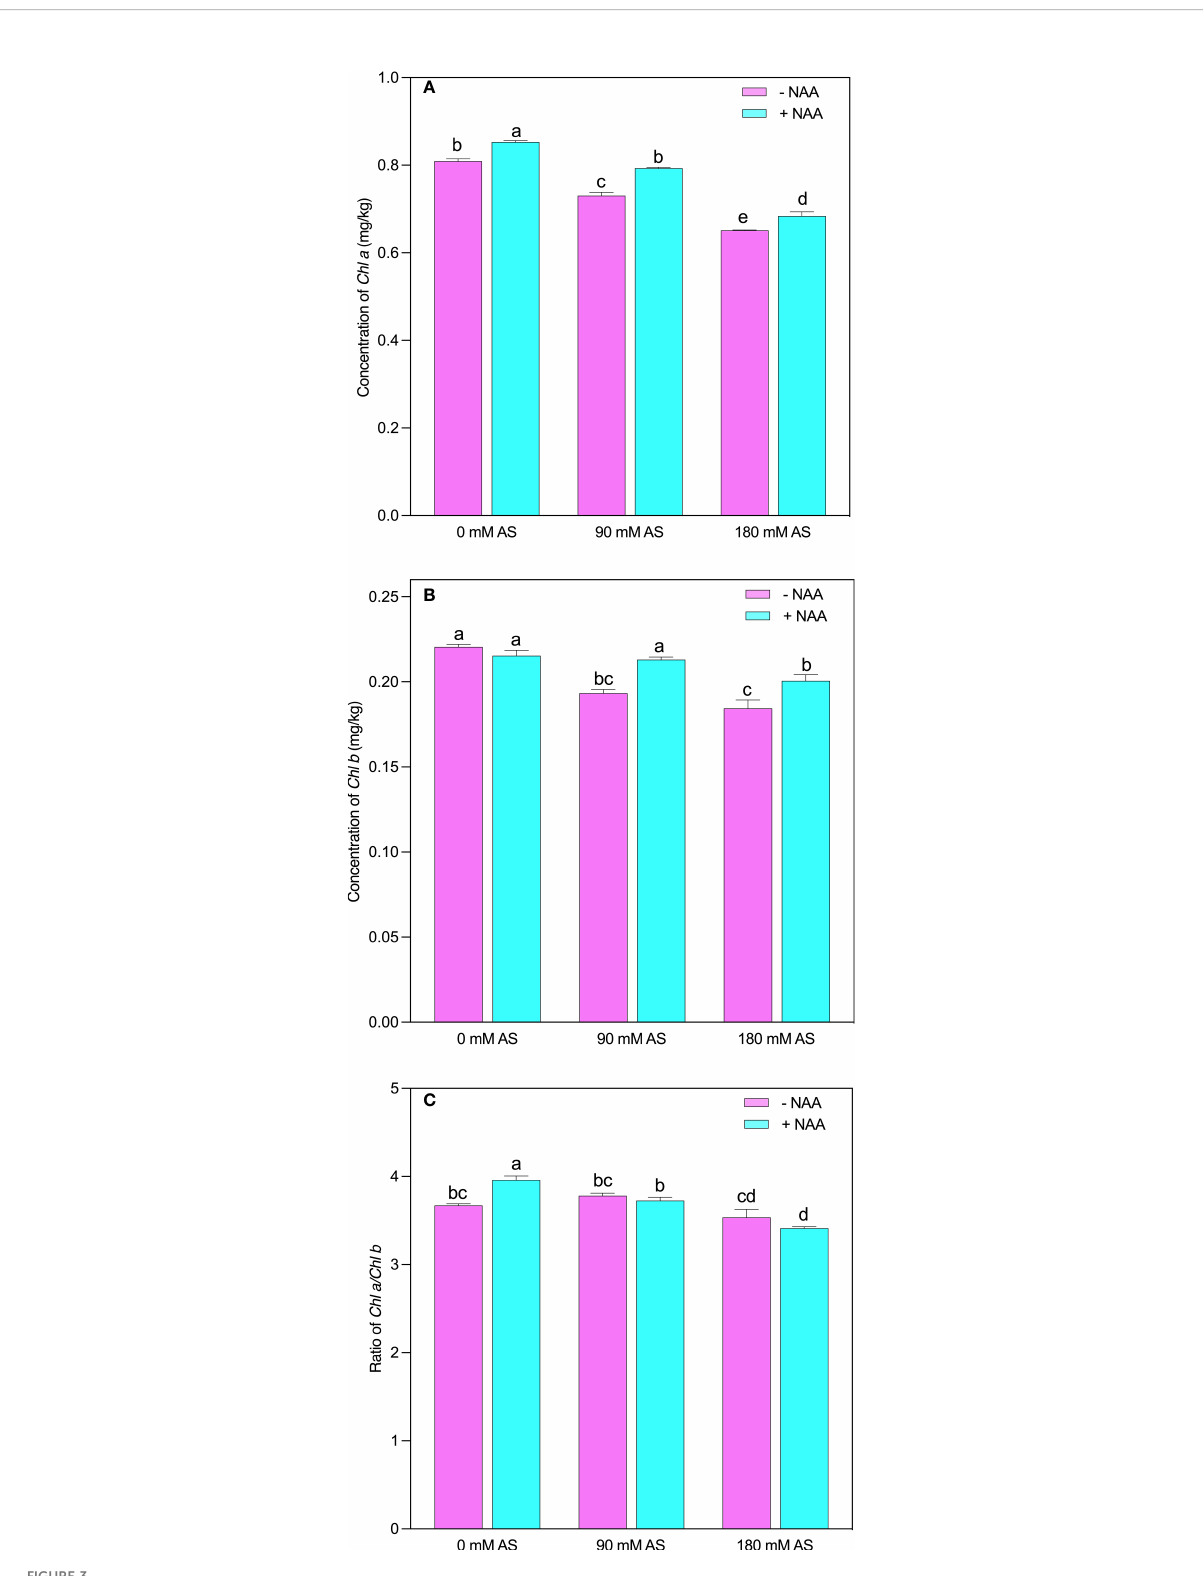
FIGURE 3 Changes in concentrations of (A) chlorophyll a (B) chlorophyll b and (C) ratio of chlorophyll a / b in chufa plants under alkaline stress (AS) and exogenous naphthaleneacetic acid (NAA) application. Bars represents SD of mean, n=3. Different letters indicate signi fi cantly different values at P <0.05 (Duncan ’ s